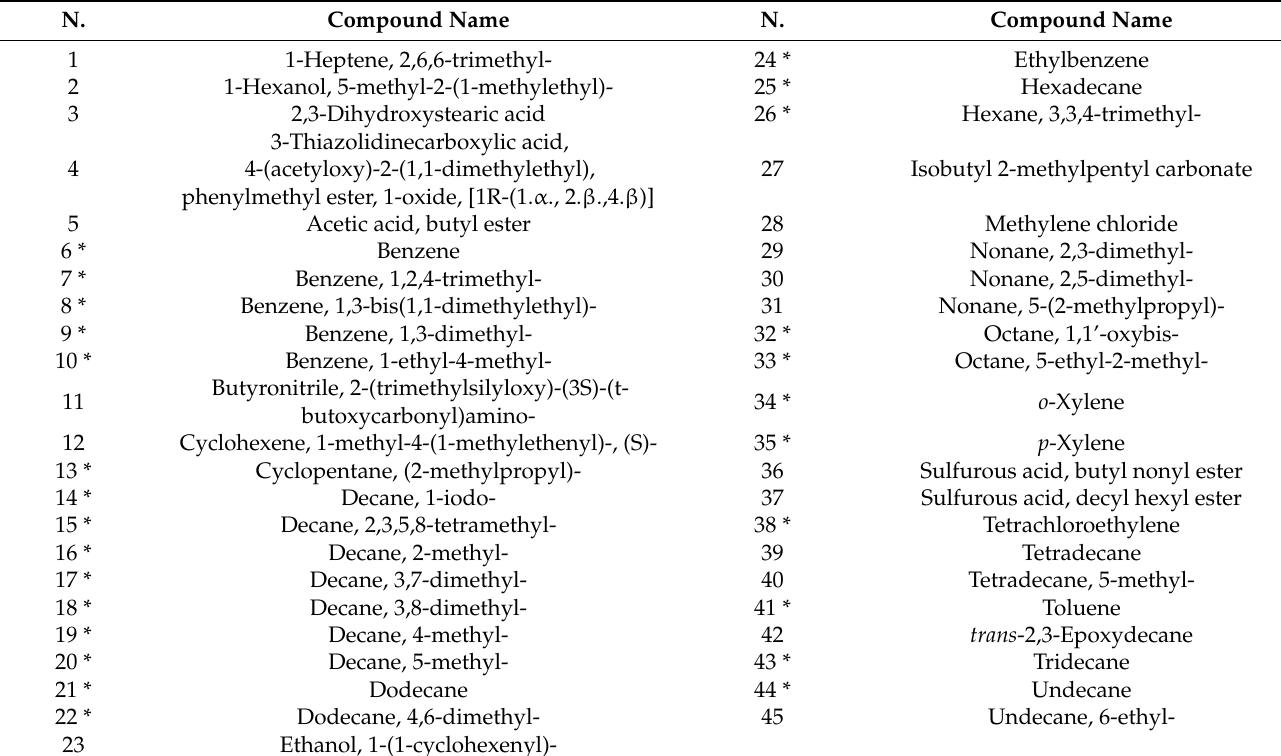
Table 1. List of olive tree VOCs identified in this work. Radiello ® technology was used to trap the VOCs during the experiments. After seven days of exposure, VOCs were chemically desorbed from the cartridges and analyzed by GC-MS. The asterisk (*) indicates air contaminants